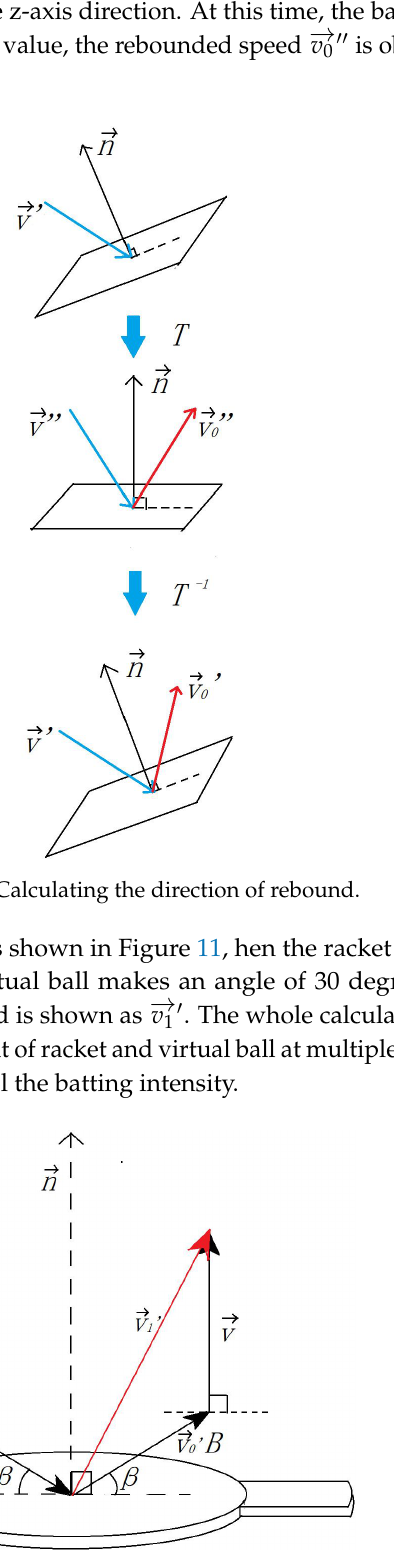
Figure 11. Relationship between rebound speed and speed of